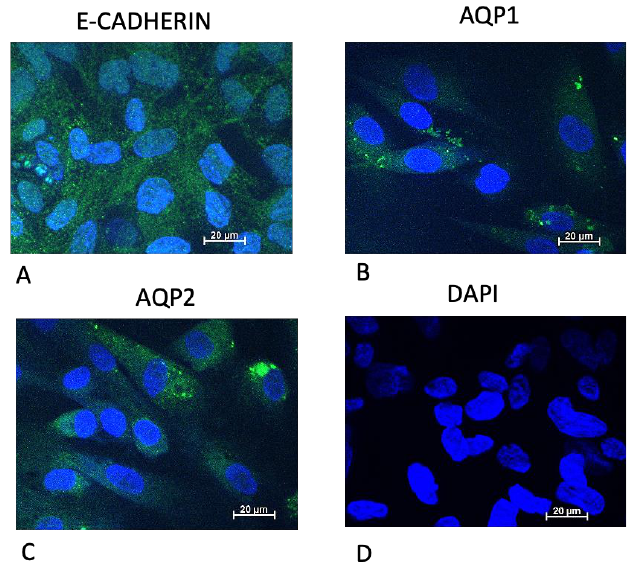
Figure 1. Transmission Electron Microscopy (TEM) was used to provide morphologic information on cells at the fourth passage of culture. Panels ( A – C ): morphology, intracellular glycogen deposits, and organelles of URECs from a GSD1a patient; panels ( D – F ): morphology, organelles, and cilia of URECs from a control subject.